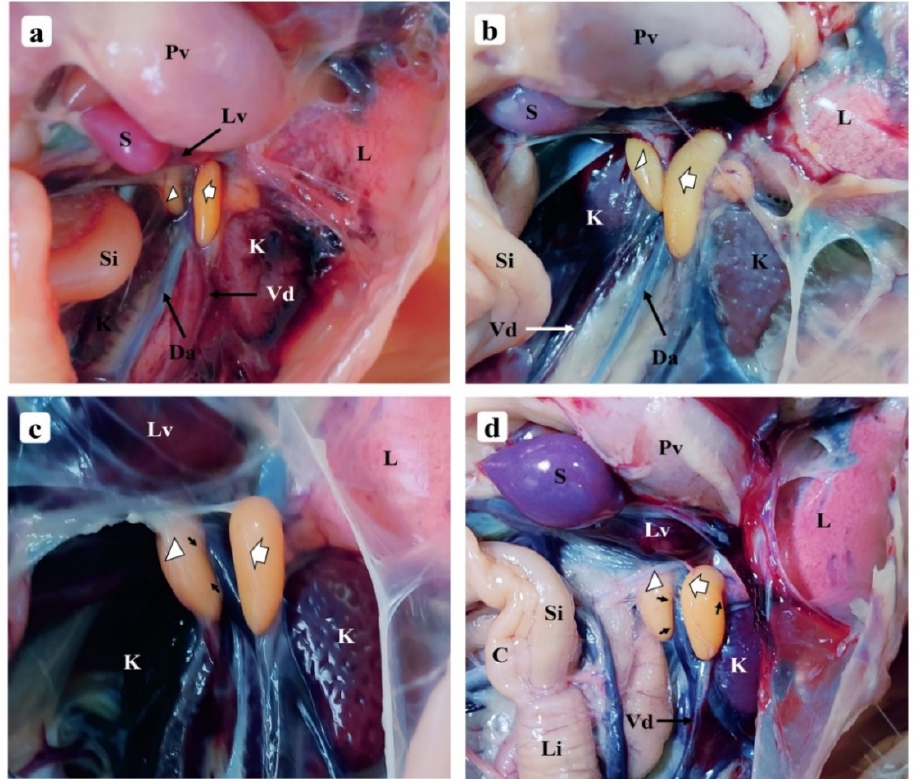
Figure 1. Morphological photographs of chicken testes during growth from 1-wk-old to 1.5-mo-old: ( a ) 1-wk-old; ( b ) 3-wk-old; ( c ) 1-mo-old; ( d ) 1.5-mo-old. Proventriculus (Pv), spleen (S), liver (Lv), the caudal end of the left lung (L), left testis (white arrow), right testis (white arrowhead), small intestine (Si), kidney (K), vas deferens (Vd), dorsal aorta (Da), vascularization growing on the testes surface (black arrows), caecum (C), large intestine (Li).